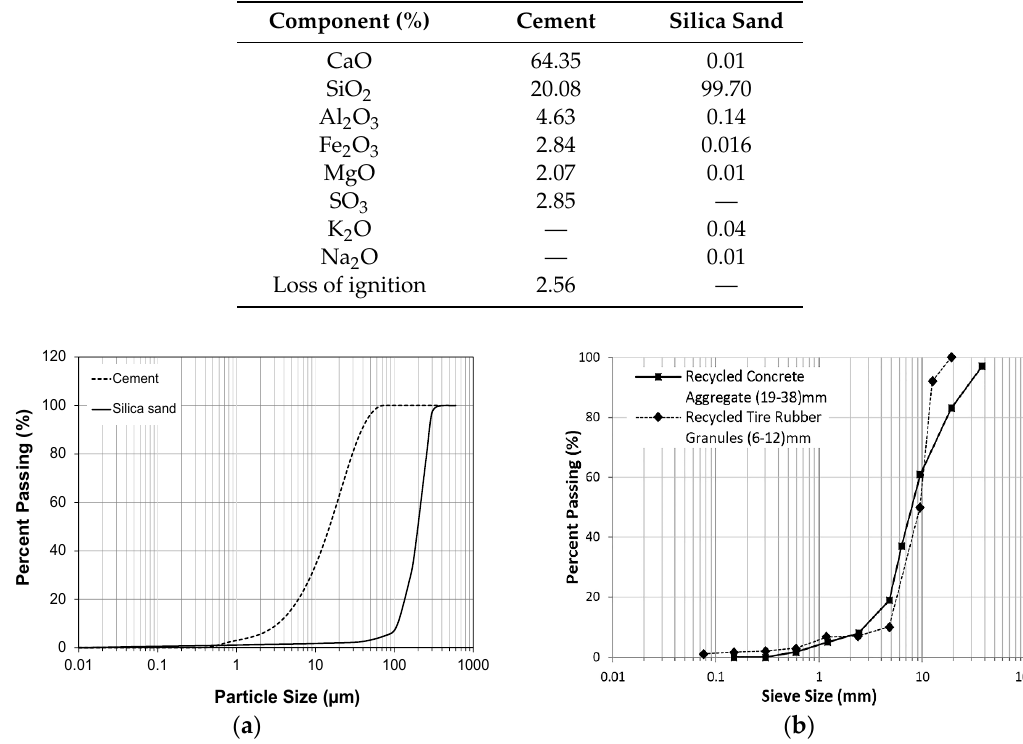
Figure 1. Particle size distribution of ( a ) cement and silica sand, and ( b ) recycled aggregate and tire rubber